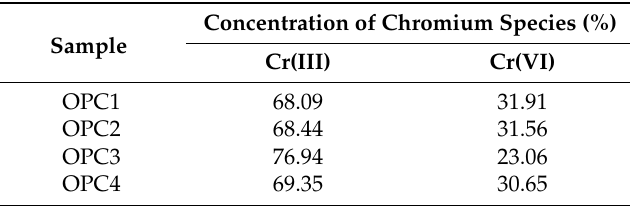
Table 5. XPS semi-quantitative analysis of the cement